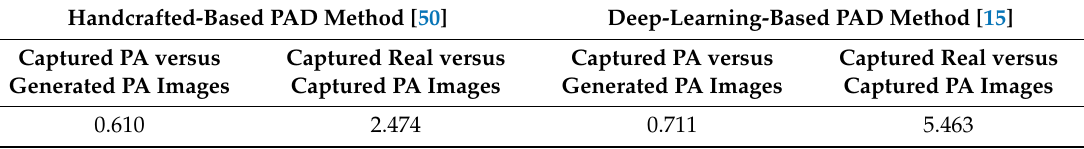
Figure 7. Distribution of detection scores for captured PA images versus the generated PA images with the CASIA dataset ( a ) using the handcrafted-based face-PAD system [50]; ( b ) using the deep-learning-based face-PAD system [15]. Table 8. PadD measurements of generated PA images using the CASIA